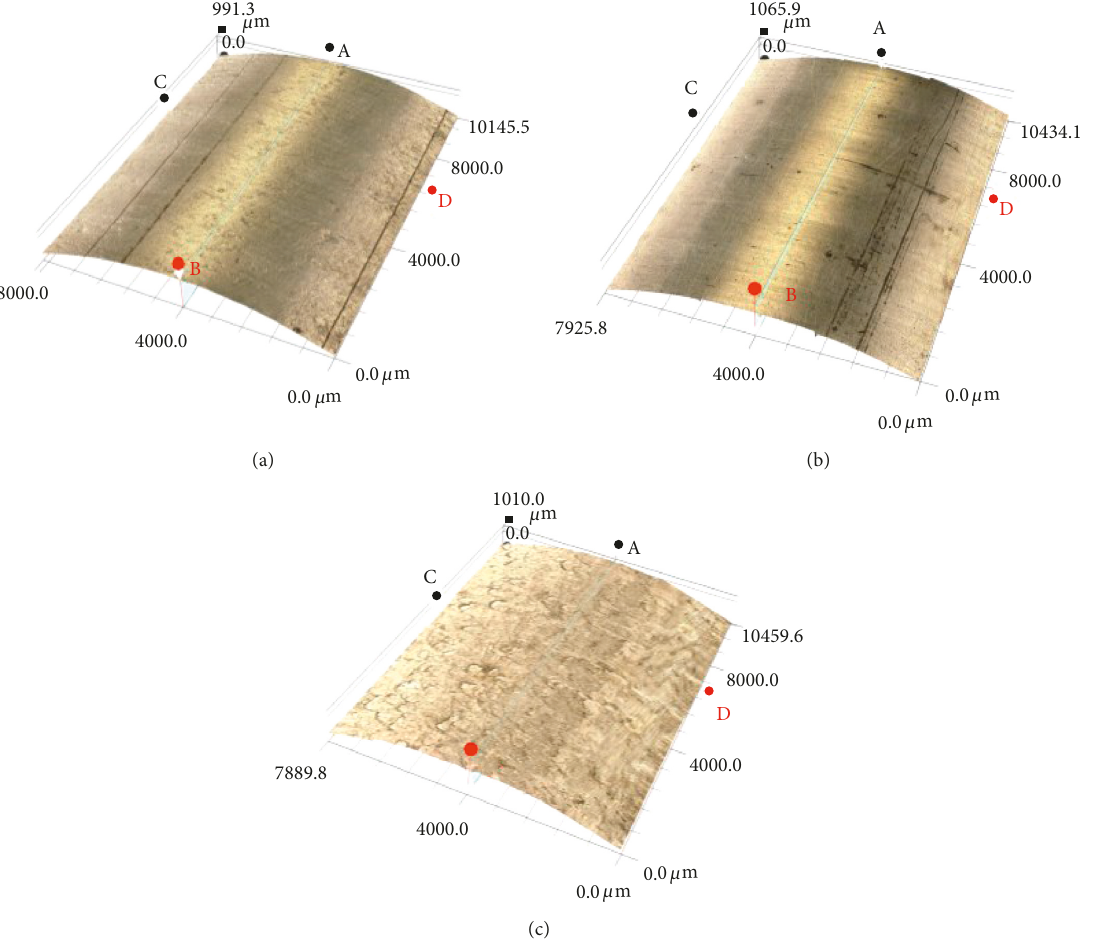
Figure 15: Tube after spinning under different feed ratios. (a) R t 0.2mm. (c) R (cid:31) Δ